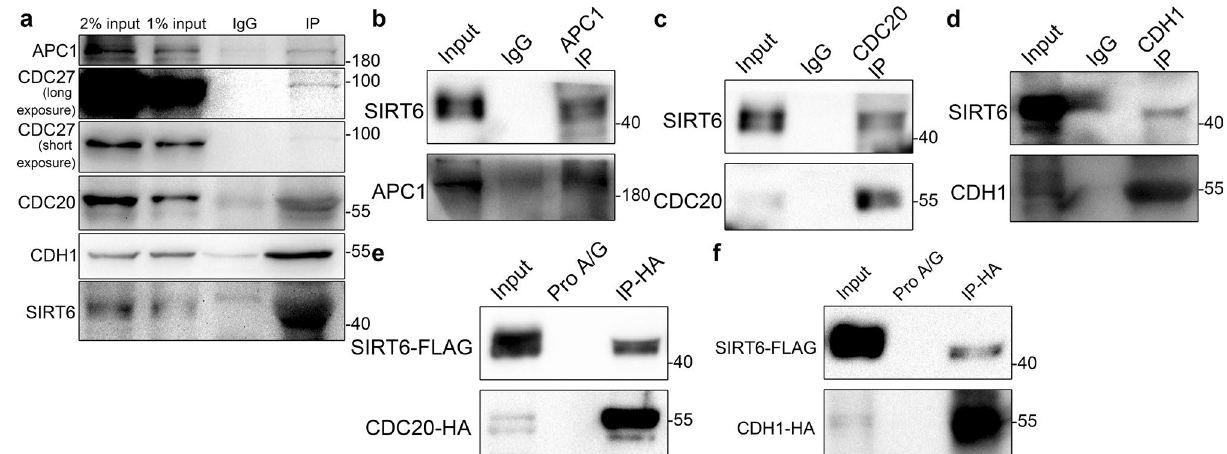
Figure 2. SIRT6 interacts with APC/C. ( a ) Lysates of asynchronous HeLa cells were immunoprecipitated (IP) with an anti-SIRT6 antibody or normal IgG, and then the immunoprecipitates were analyzed by immunoblotting. ( b–d ) Lysates of asynchronous HeLa cells were immunoprecipitated with anti-APC1 (b), anti-CDC20 (c), anti-CDH1 (d) antibody, or normal IgG, and then the immunoprecipitates were analyzed by immunoblotting. ( e , f ) Lysates of HeLa cells stably expressing CDC20-HA/CDH1-HA along with SIRT6- FLAG were immunoprecipitated with anti-HA antibody, and then the immunoprecipitates were analyzed by immunoblotting. Protein A/G was used as an unspecific control. Images of CDC20-HA, SIRT6-FLAG and CDH1-HA with the short exposure time are shown in the original image section in the supplementary